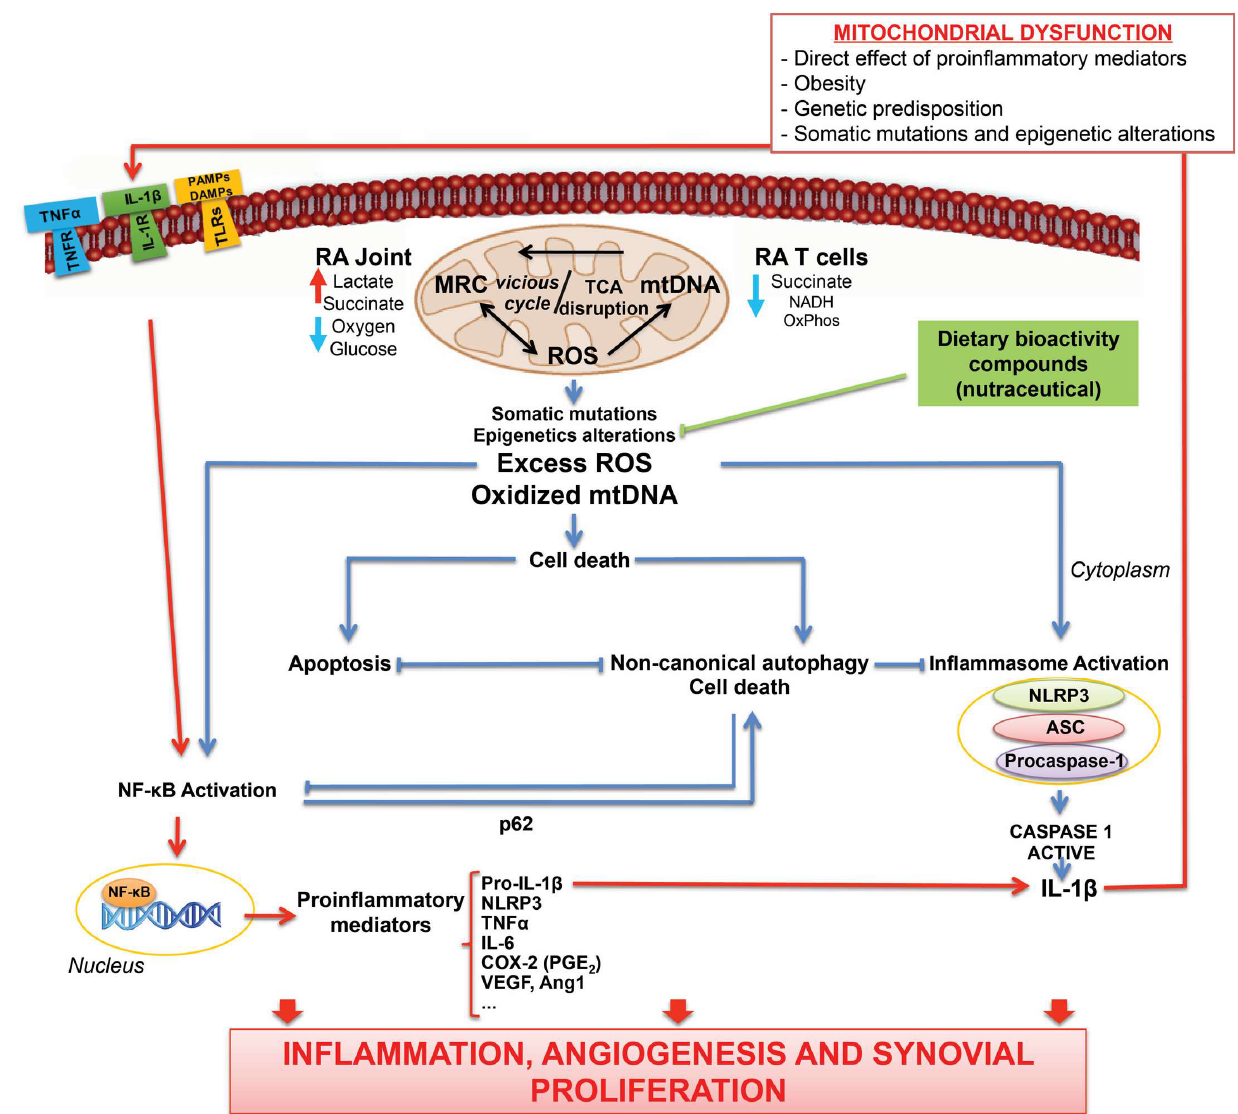
Figure 1. Theoretical model for the multidirectional interplays between mitochondrial oxidative stress, metabolic status, inflammation and cell death in RA. Mitochondria play essential roles at the crossroads of metabolism and innate immunity [54]. Thus, mitochondrial dysfunction derived from several danger signals could activate TCA disruption and thereby favoring a vicious cycle of oxi- dative/mitochondrial stress. In fact, oxidative damage in synovial tissue is associated with in vivo hypoxic status, high lactate and low glucose levels [3]. Mitochondrial dysfunction can act through modulating innate immunity via redox-sensitive inflammatory pathways (i.e., NF-κB) or direct ac- tivation of the inflammasome. Inflammasome activation and NF-κB pathway could work together to activate inflammatory cytokines, thereby leading to overstimulation of the inflammatory re- sponse. On the other hand, mitochondria also have a central position in regulating cell death. In this sense, the two main regulated cell death pathways, apoptosis and autophagy, cooperate in a balanced interaction that promotes cell survival or cell death. Additionally, NF-κB could restrict inflammasome activation via elimination of damaged mitochondria through p-62-dependent clearance of damaged mitochondria as well as autophagy modulate NF-κB activation [135]. Addi- tionally, multiple evidence suggests that pathological processes in RA can be shaped by epigenetic mechanisms and that mitochondria are involved in epigenetic regulation [241]. Natural bioactive agents of a healthy diet could protect mitochondria and inhibit the overactivation of mitochondrial oxidative stress and the associated inflammatory response that define RA.